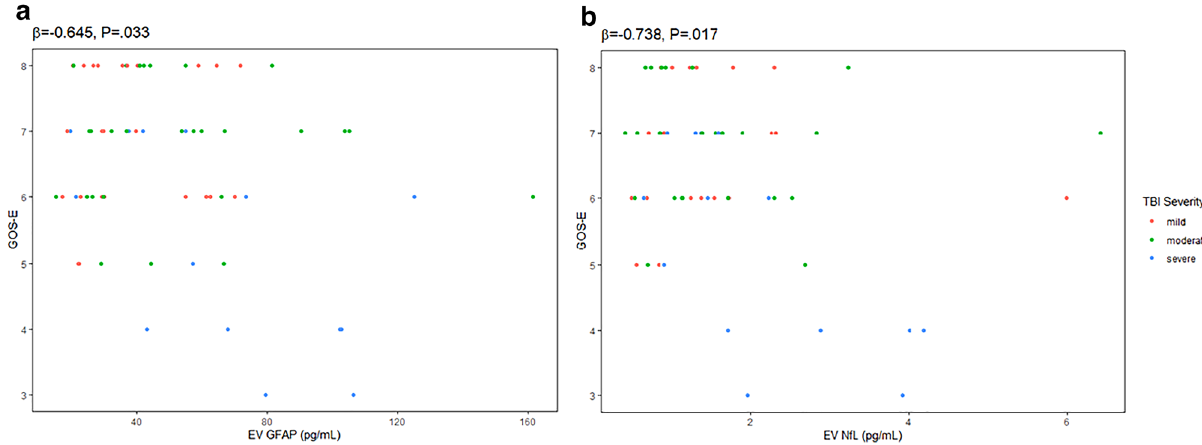
Figure 3. Correlations between 1 year ( a ) EV GFAP (N = 68) and ( b ) EV NfL (N = 59) concentrations and outcomes at 1 year, controlling for age and sex. GOS-E Glasgow Outcome Scale-Extended, GFAP glial fibrillary acidic protein, NfL neurofilament light, EV extracellular vesicle.